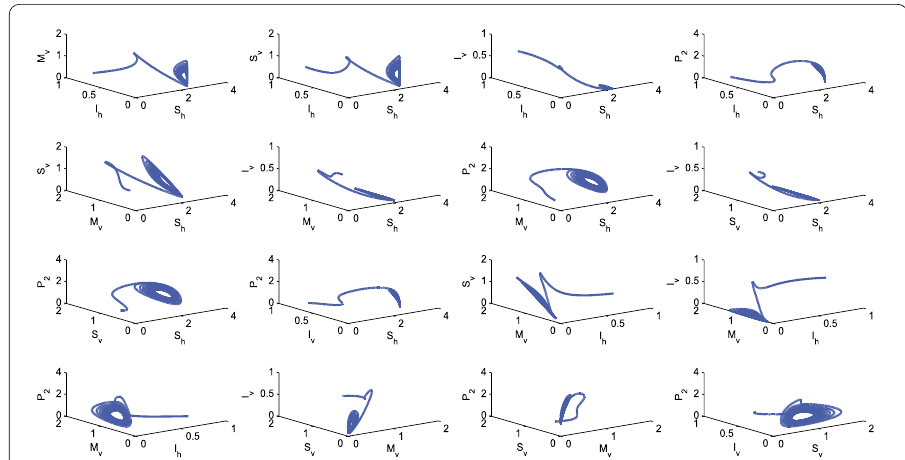
Figure 5 Stable limit cycle for system (1) with parameters given in Example 3